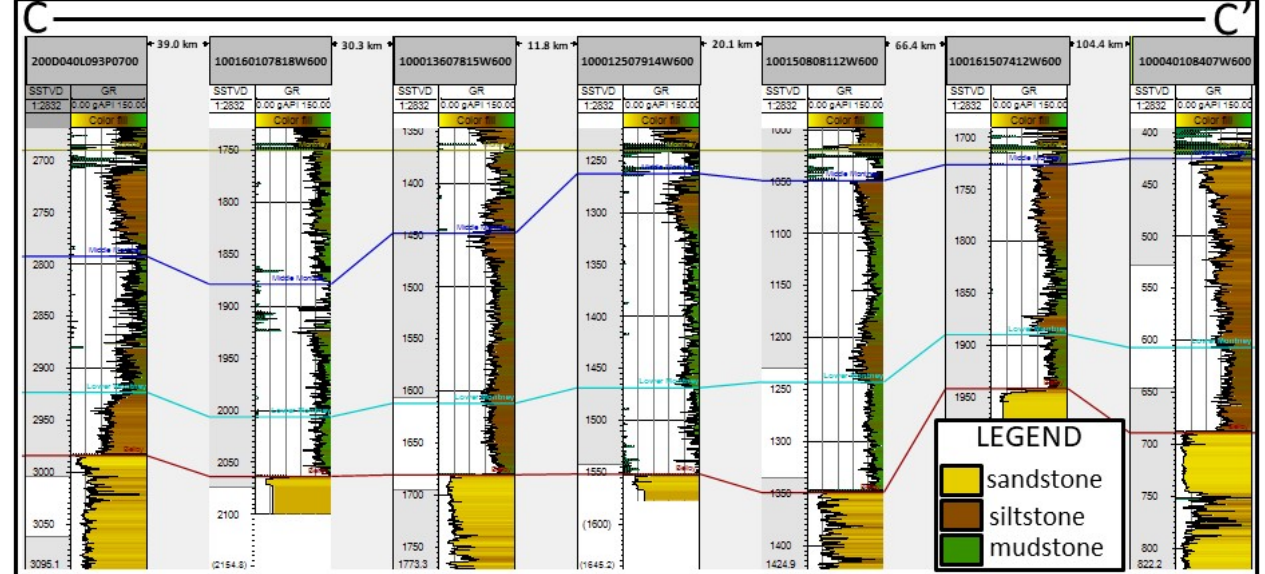
Figure 30. NE-SW cross-section along the depositional dip near the Dawson Creek area. See Figure 24 for the location of the cross-section C–C ′ . The Upper Montney Top is the brownish yellow line, the Middle Montney Top is the dark blue line, the Lower Montney Top is light bluish green line, and the base of the Montney at the Belloy Top is the dark red line. The Upper Montney subunit becomes thinner, and the overall gamma ray values for the Montney formation decrease towards the NE into Alberta.